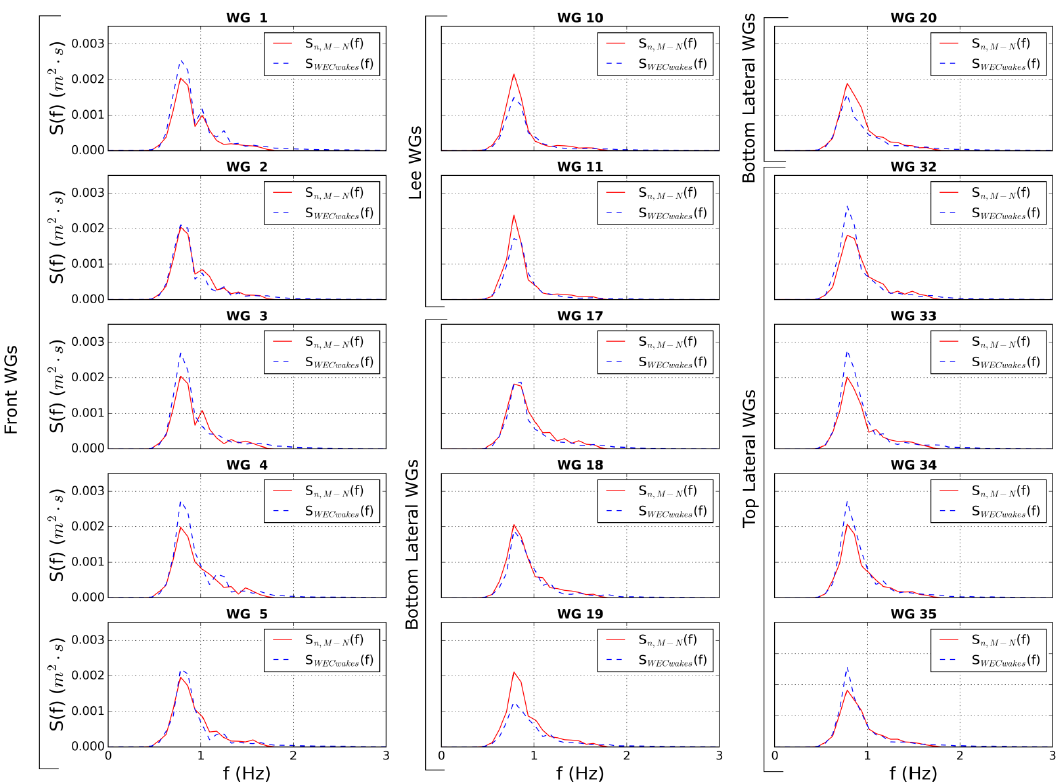
Figure 8. Comparison between the spectral density S n , M − N ( f ) obtained using the MILDwave-NEMOH coupled model, and the spectral density from the WECwakes experimental data, S WECwakes ( f ) for all 15 WGs of Figure 1A for Test Case 6 of Table